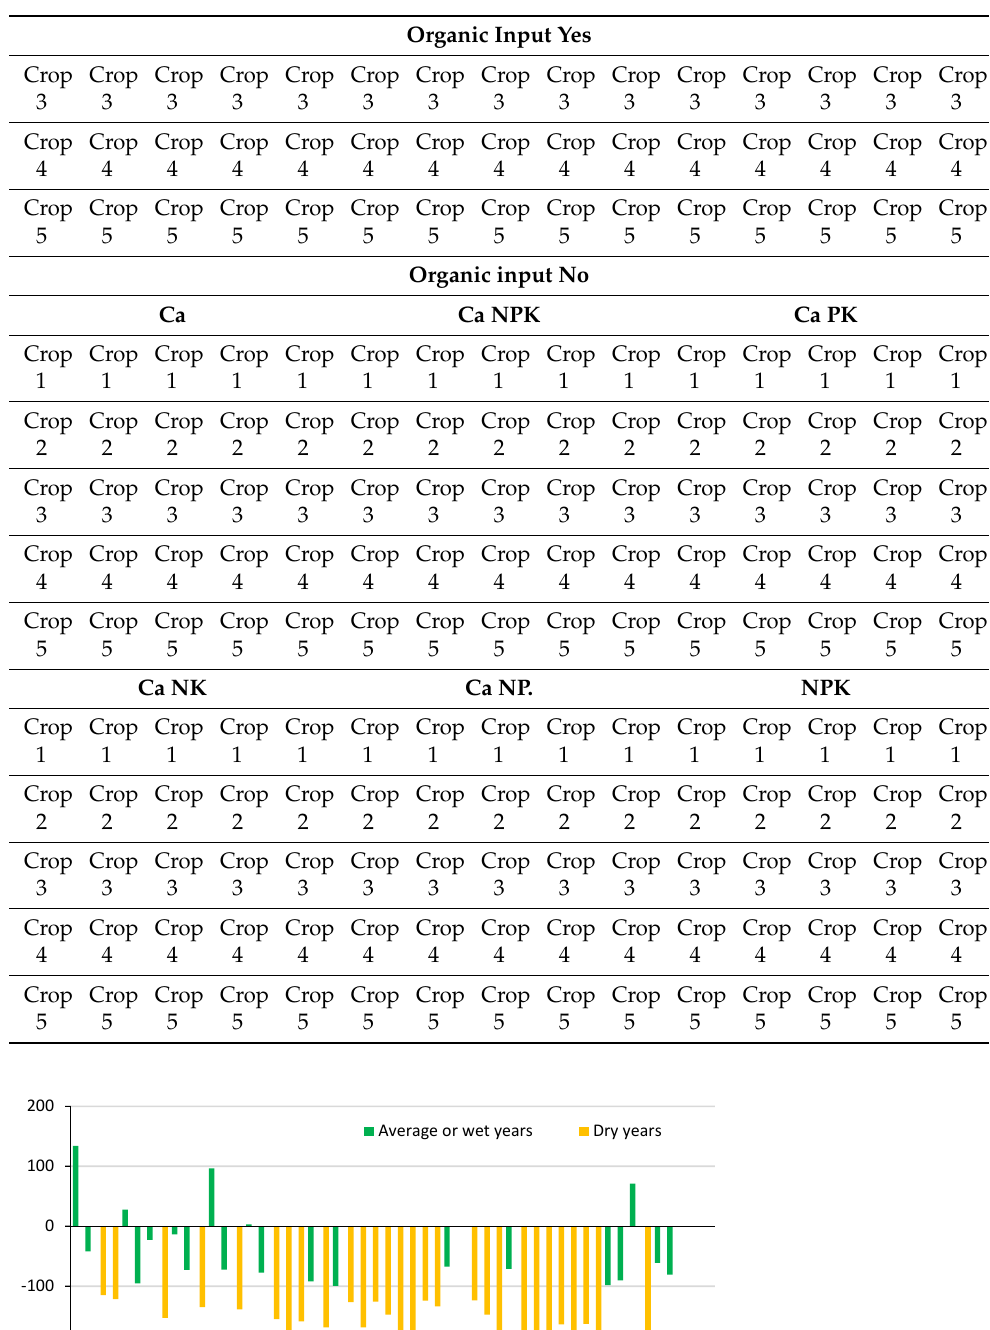
Table A1. Field plan of the Skierniewice long-term experiment (1966–2015). Five-year crop rotation: potato (crop 1)-spring barley (crop 2)-red clover (crop 3)-winter wheat (crop 4)-winter rye (crop 5). Organic Input Yes Ca Ca NPK Ca PK